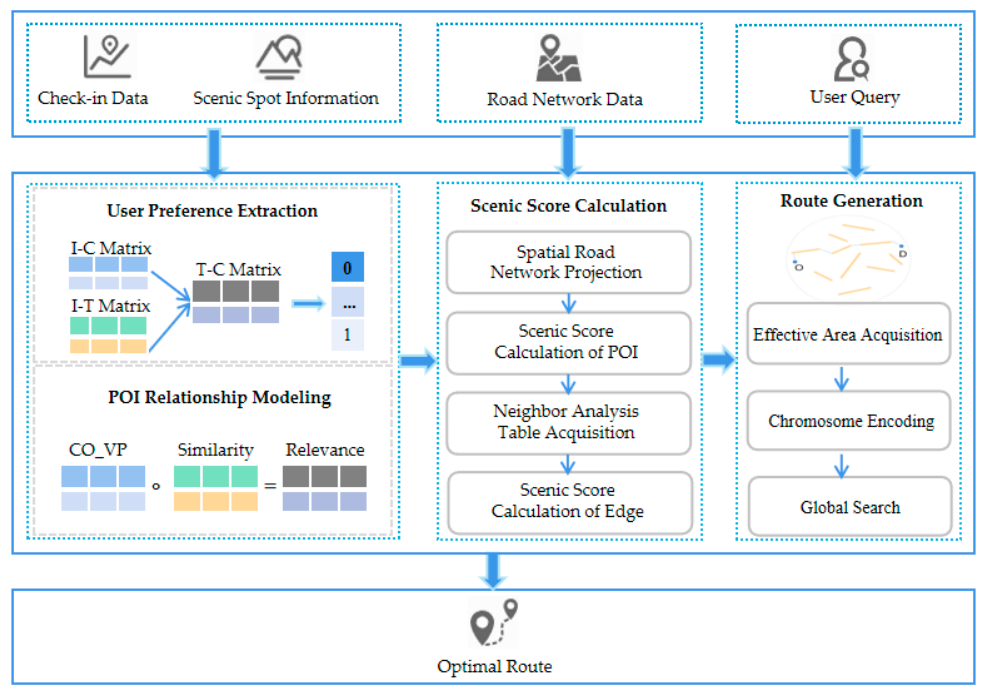
Figure 1. Overview of personalized scenic tourism route planning